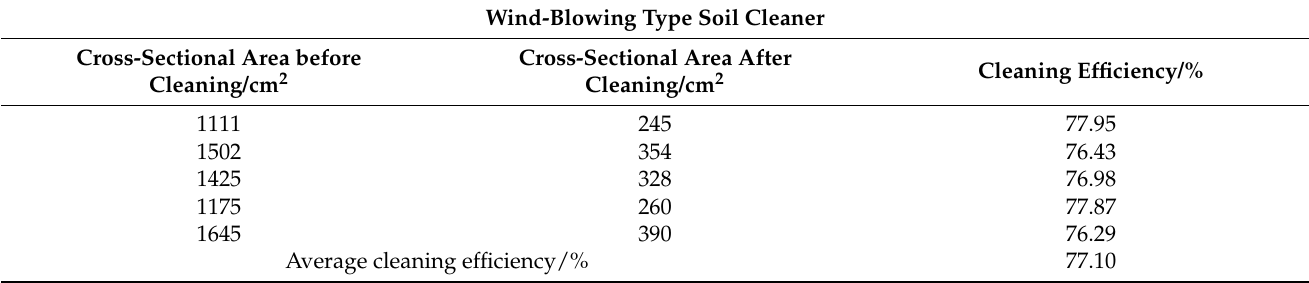
Table 10. Results of performance